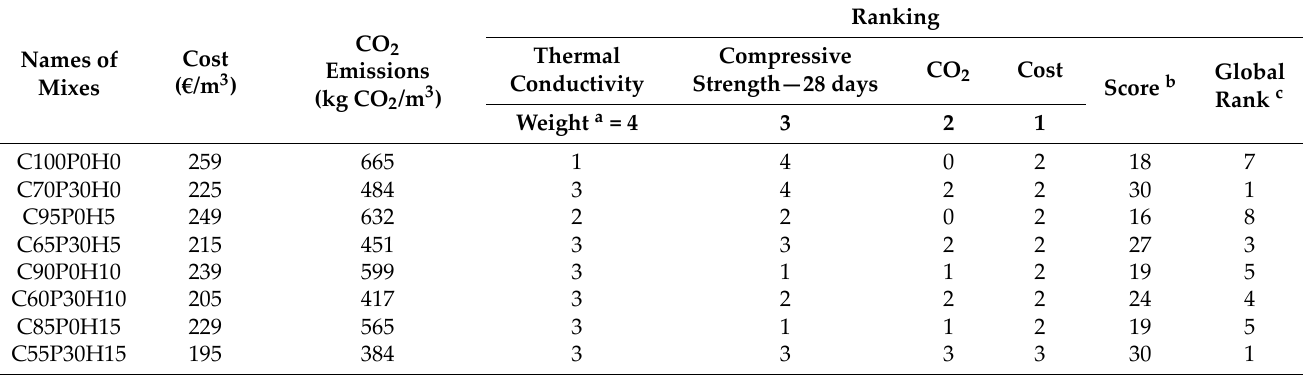
Table 5. BFCs multi‑criteria